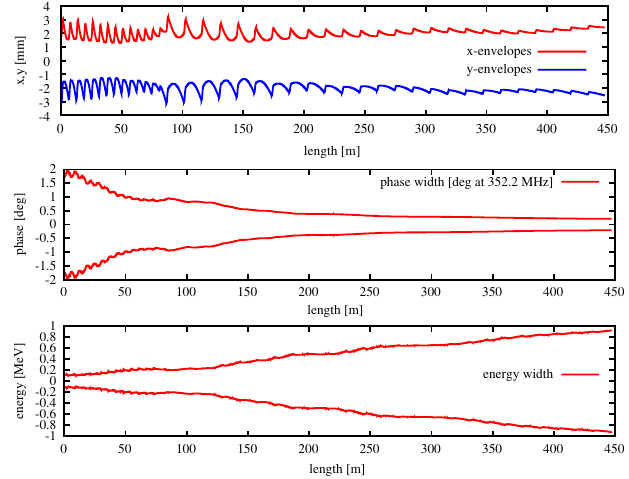
FIG. 4. (Color) Nominal beam envelopes in the nominal 704.4 MHz